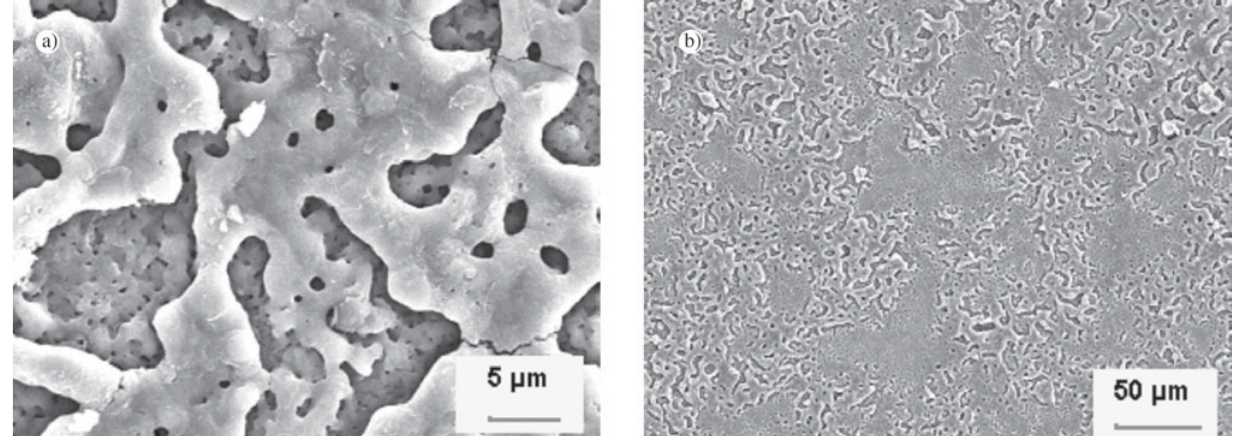
Figure 2 . Scanning electron micrograph of anodic film formed at 90 V on AZ91HP.